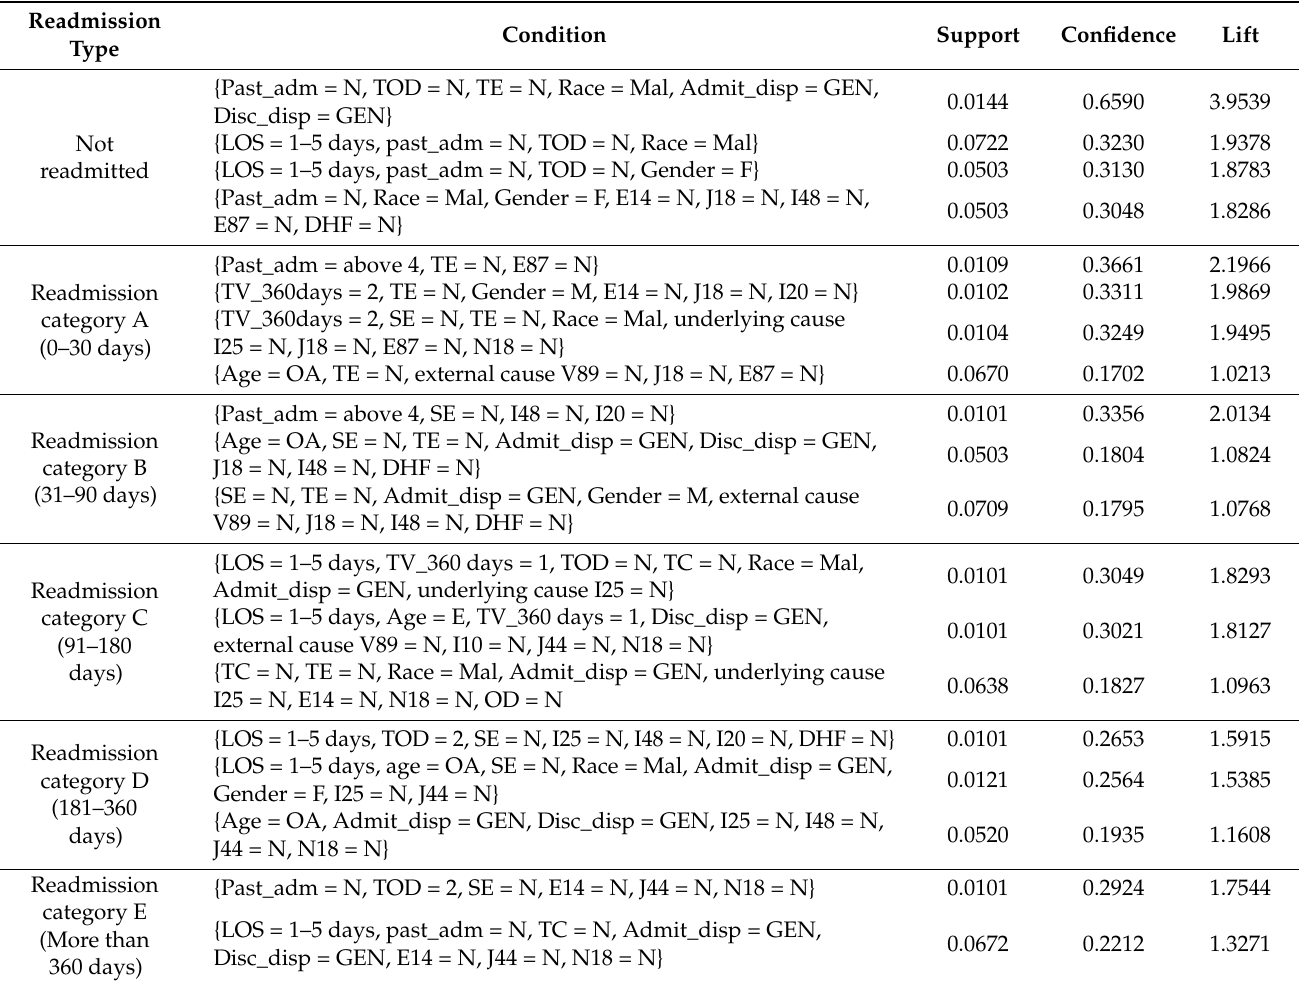
Table 3. ARM for supervised learning based on different readmission